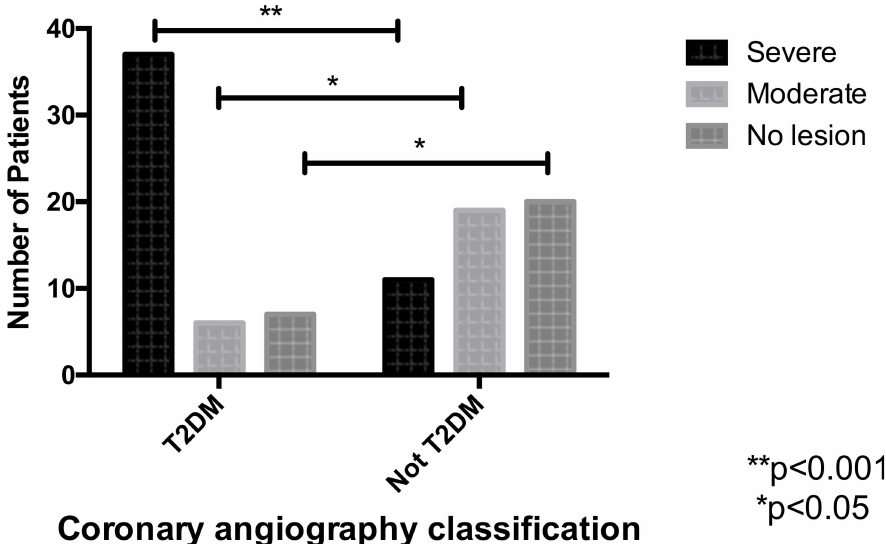
Fig 1. Coronary angiography classification. * p < 0.05 ** p < 0.001.